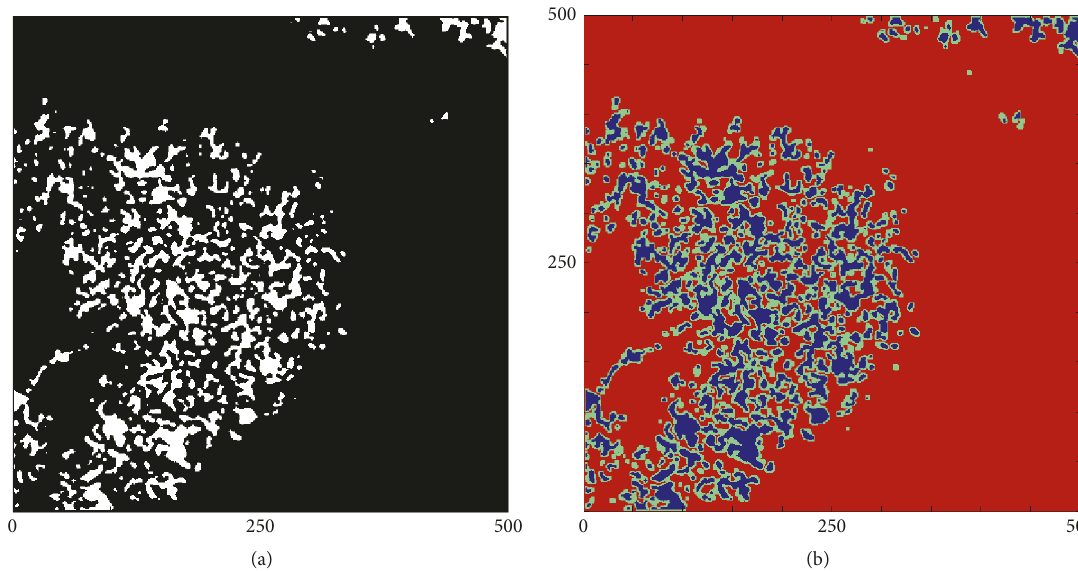
Figure 6: Input files, with (a) binary CT image and (b) conversion to geometry file in which fluid voxels are blue (value 0), internal rock voxels are red (value 2), and boundary voxels are green (value 1).